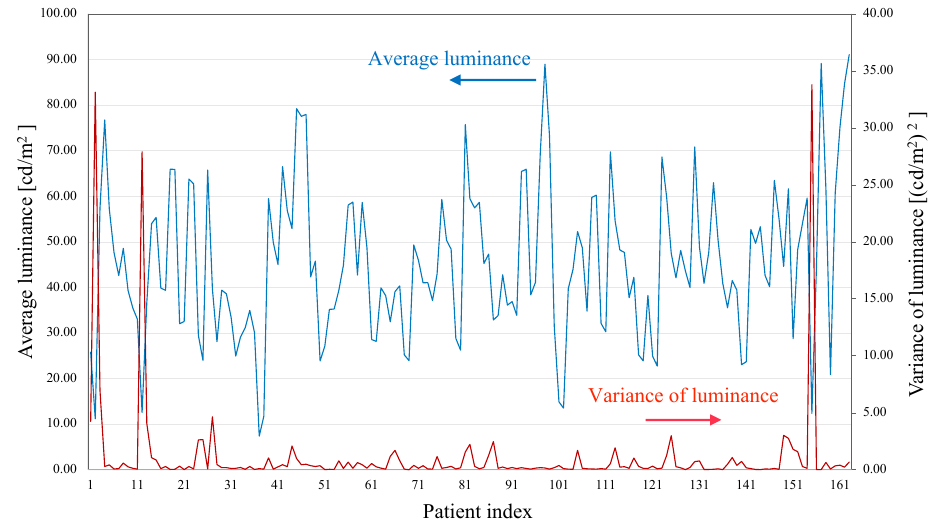
Figure 15. Average and variance of measured luminance for all patiants with optimal kernel N = 113.